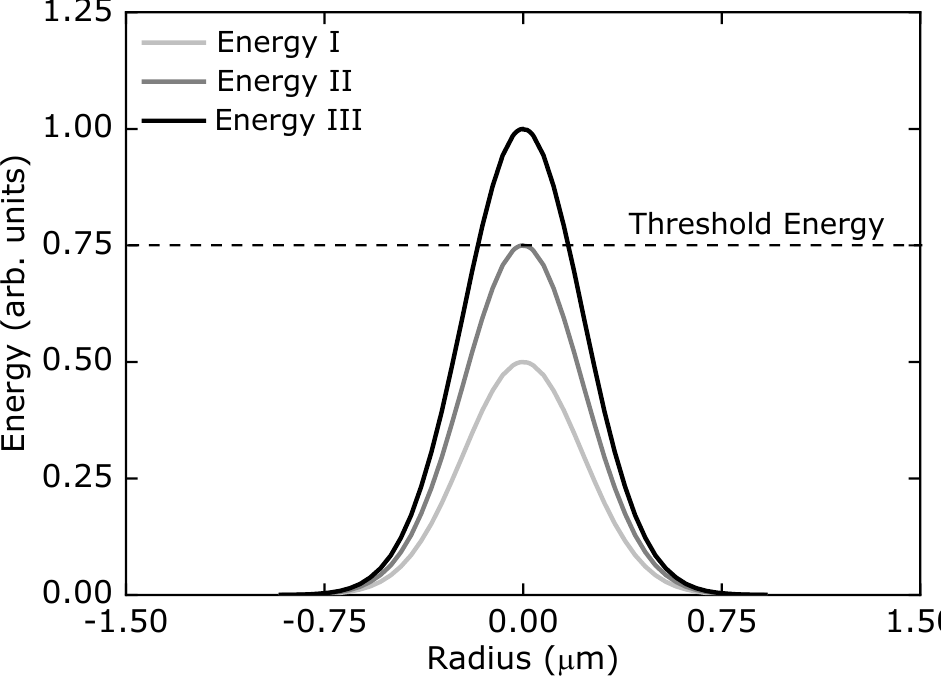
Figure 4. Threshold power relative to various Gaussian profiles. Polymerization is not observed if peak power is below the threshold power.